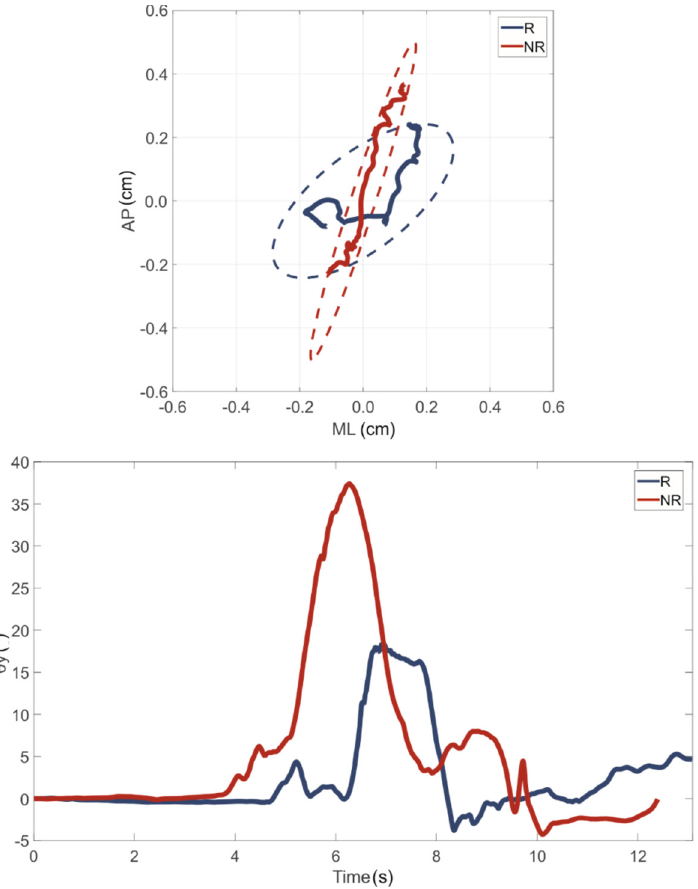
Figure 3. Example of ( top ) path length in xy plane during mCMJ and ( bottom ) angle waveform during SLS. Blue and red lines indicate results related to the subjects in the R and NR groups, re ‐ spectively.